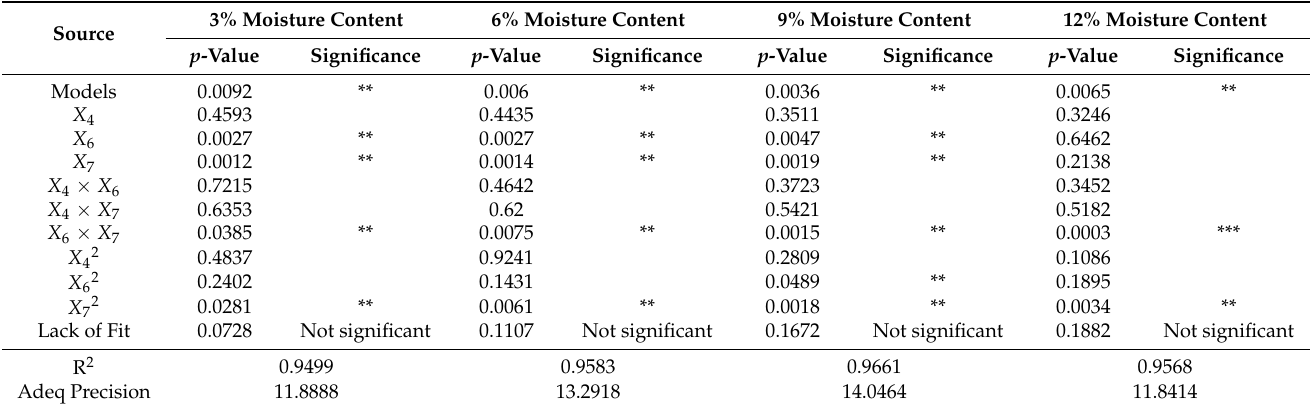
Table 10. Analysis of variance of Box–Behnken experimental regression model under different water content